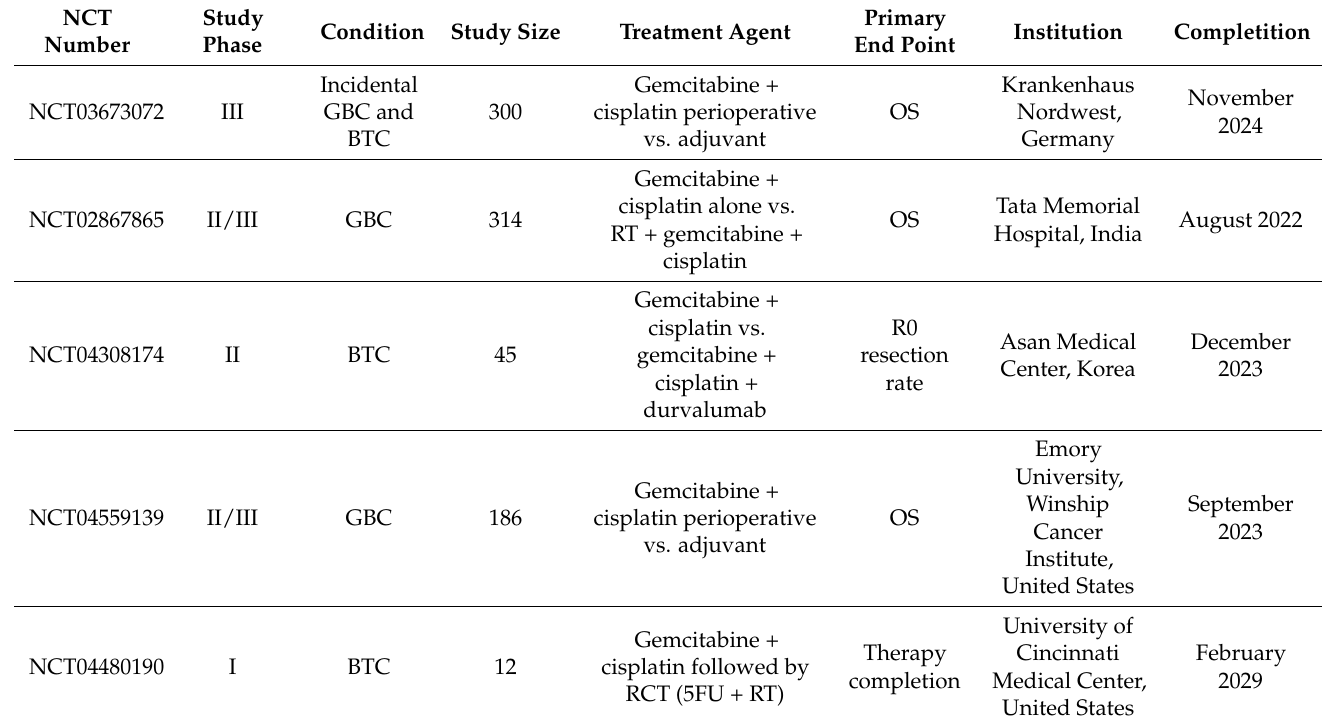
Table 1. Ongoing clinical trials for the evaluation of neoadjuvant therapy in locally advanced gallbladder cancer. BTC: biliary tract cancer. GBC: gallbladder cancer. OS: overall survival. ORR: overall response rate. RCT: radiochemotherapy. RT: